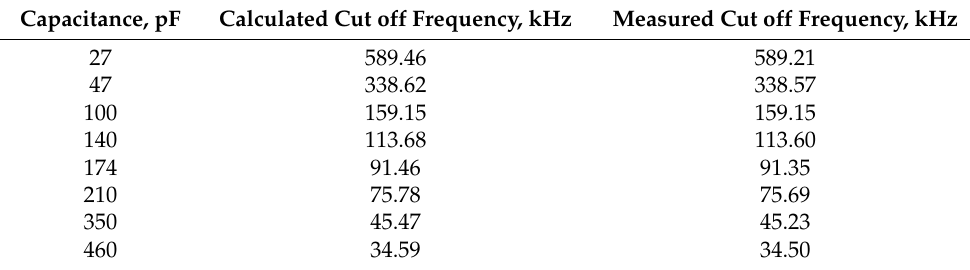
Table 3. Calculated and measured cut-off frequency of low-pass filter vs. ceramic capacitor’s simulation of the sensor